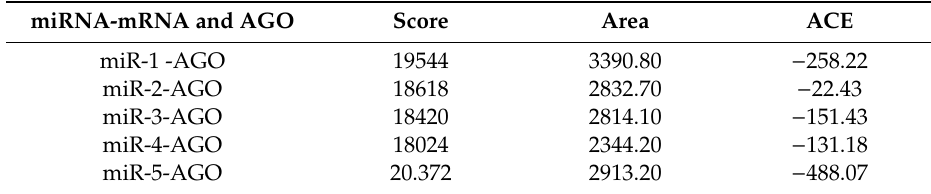
Table 6. The docking scores between miRNA and AGO